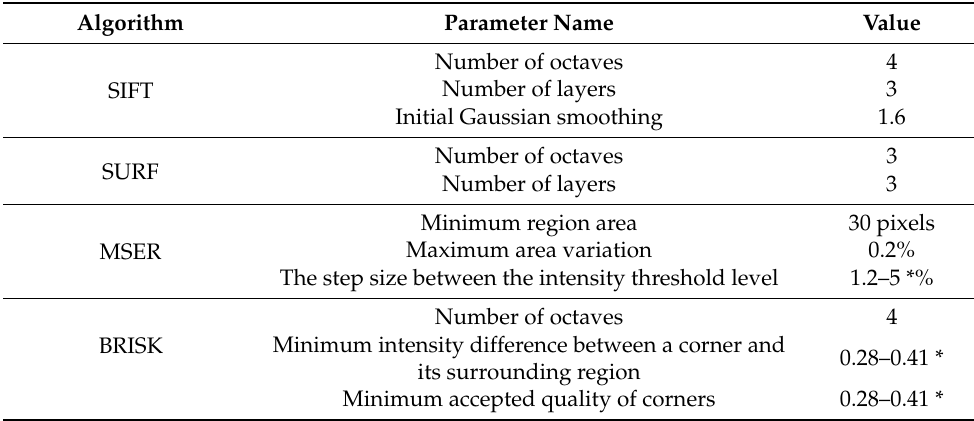
Table 1. The parameters of